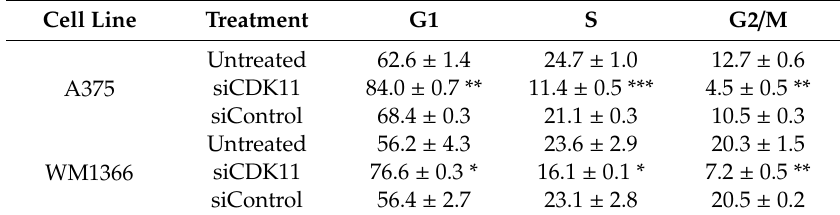
Table 6. E ff ects of siCDK11 on cell cycle distribution at 48 h